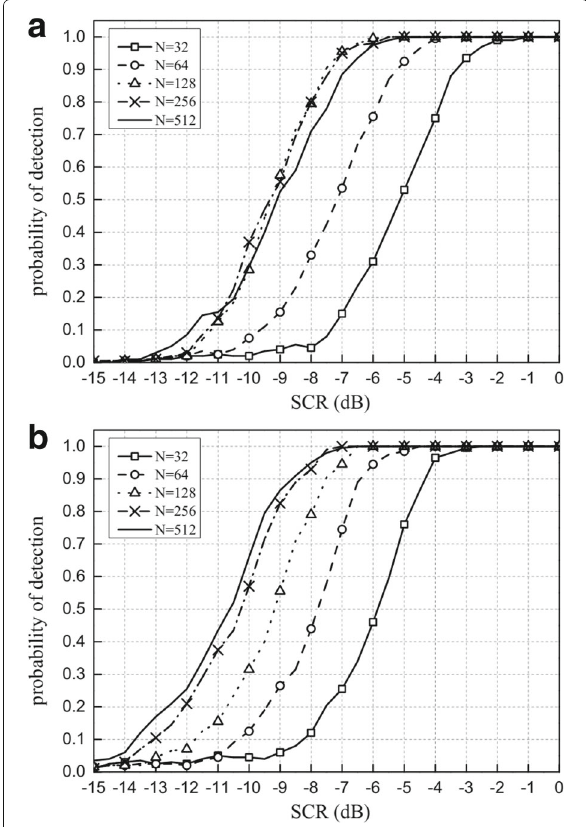
Fig. 9 Detection performance of proposed detector for N = 32,64,128,256, and 512. a target 1. b target